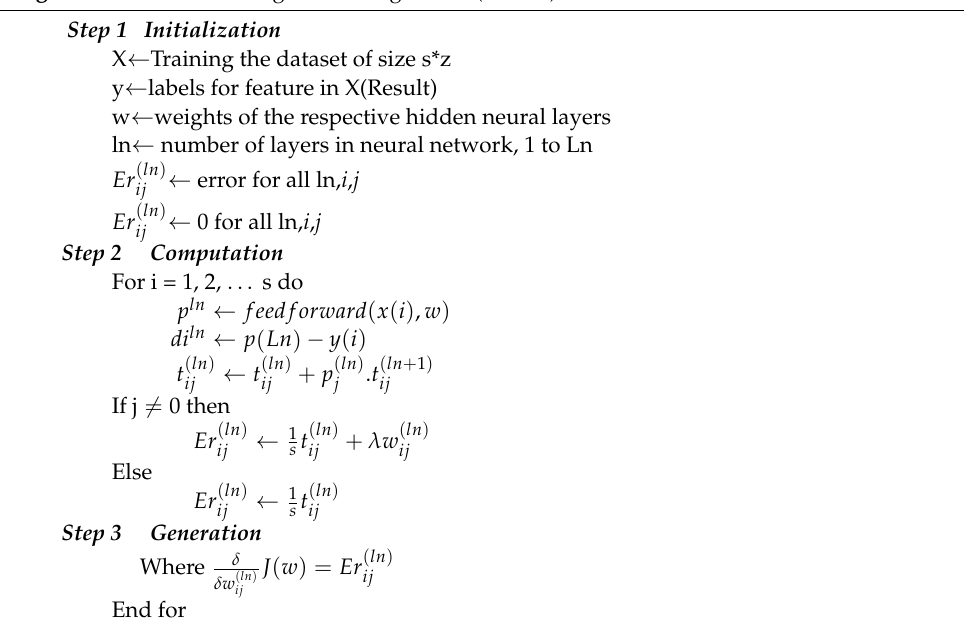
Algorithm 3: Anti Phishing Neural Algorithm